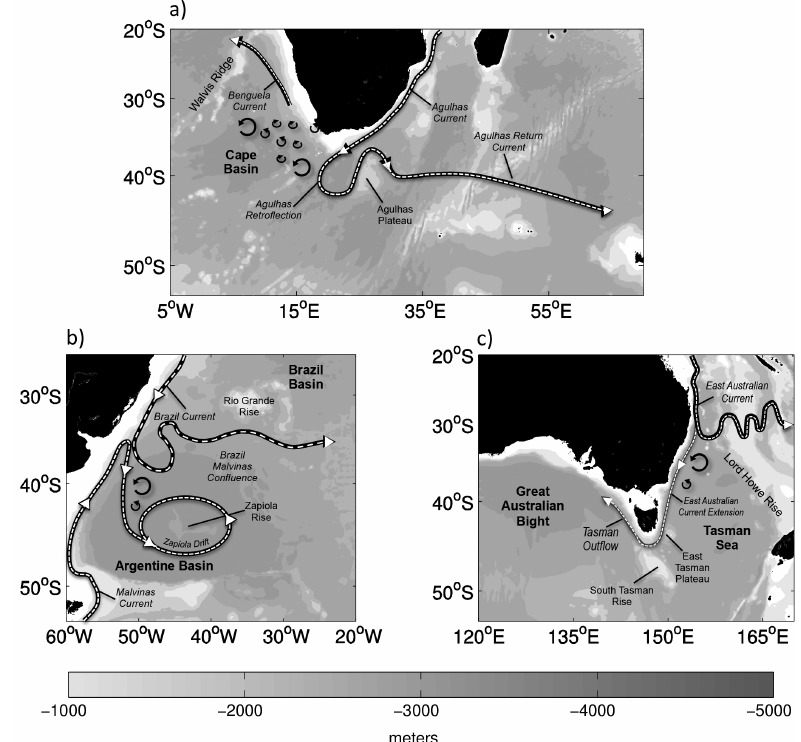
Figure 1. Main bathymetric features and circulation patterns of the (a) AC, (b) BC and (c) EAC systems (adapted from Peterson and Stramma, 1991, Cresswell, 2000, Tilburg et al., 2001, Mata et al., 2006, Matano et al.,